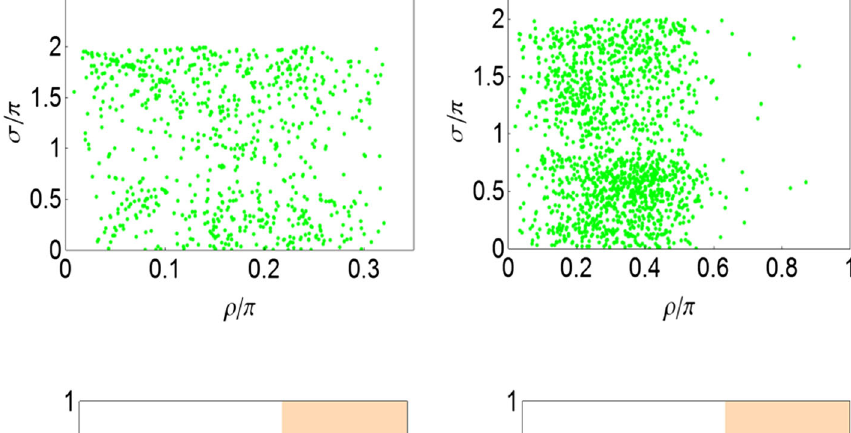
Fig. 7 Variation of the Majorana mass parameter M ee , which is an observable in neutrino-less double beta decay with lightest neutrino mass for the case of the normal (left panel) and inverted hierarchy (right panel) for tan ψ = 0